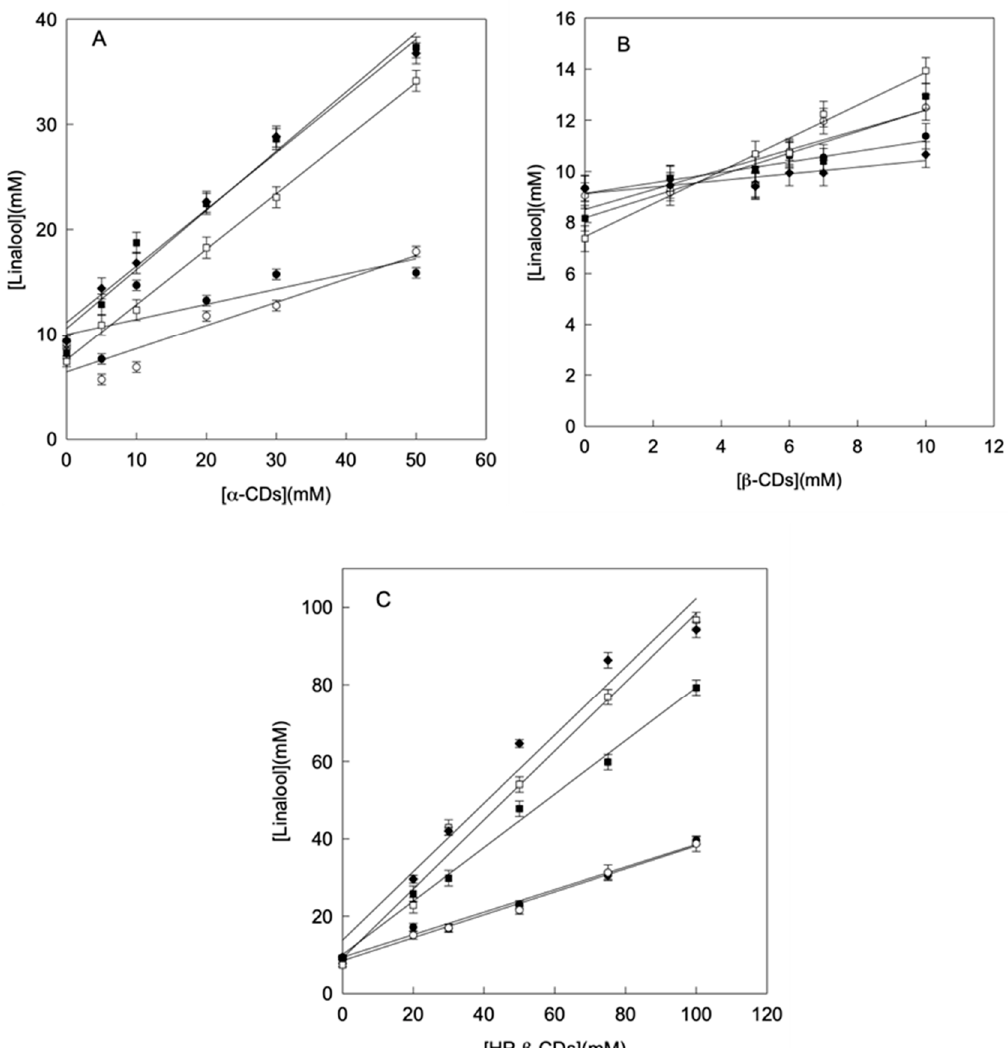
Figure 1. Phase solubility diagrams of linalool with α -CDs (A), β -CDs (B) and HP- β -CDs (C) at pH 3.5 ( ● ), pH 5.5 ( ○ ), pH 6.5 ( ■ ), pH 7.0 ( □ ) and pH 8.5 ( ♦ ). Values represent means of triplicate determination.